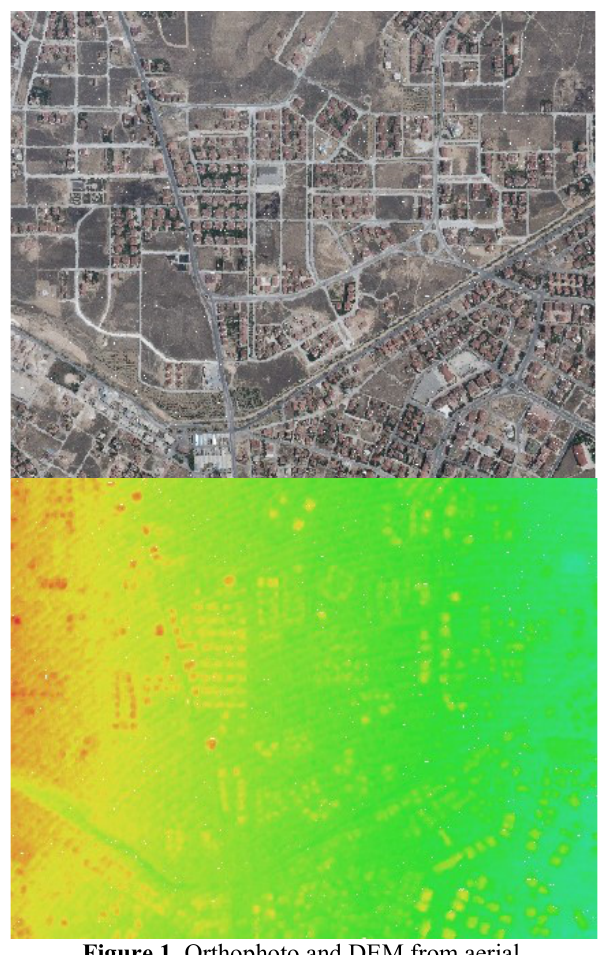
Figure 1. Orthophoto and DEM from aerial photogrammetric